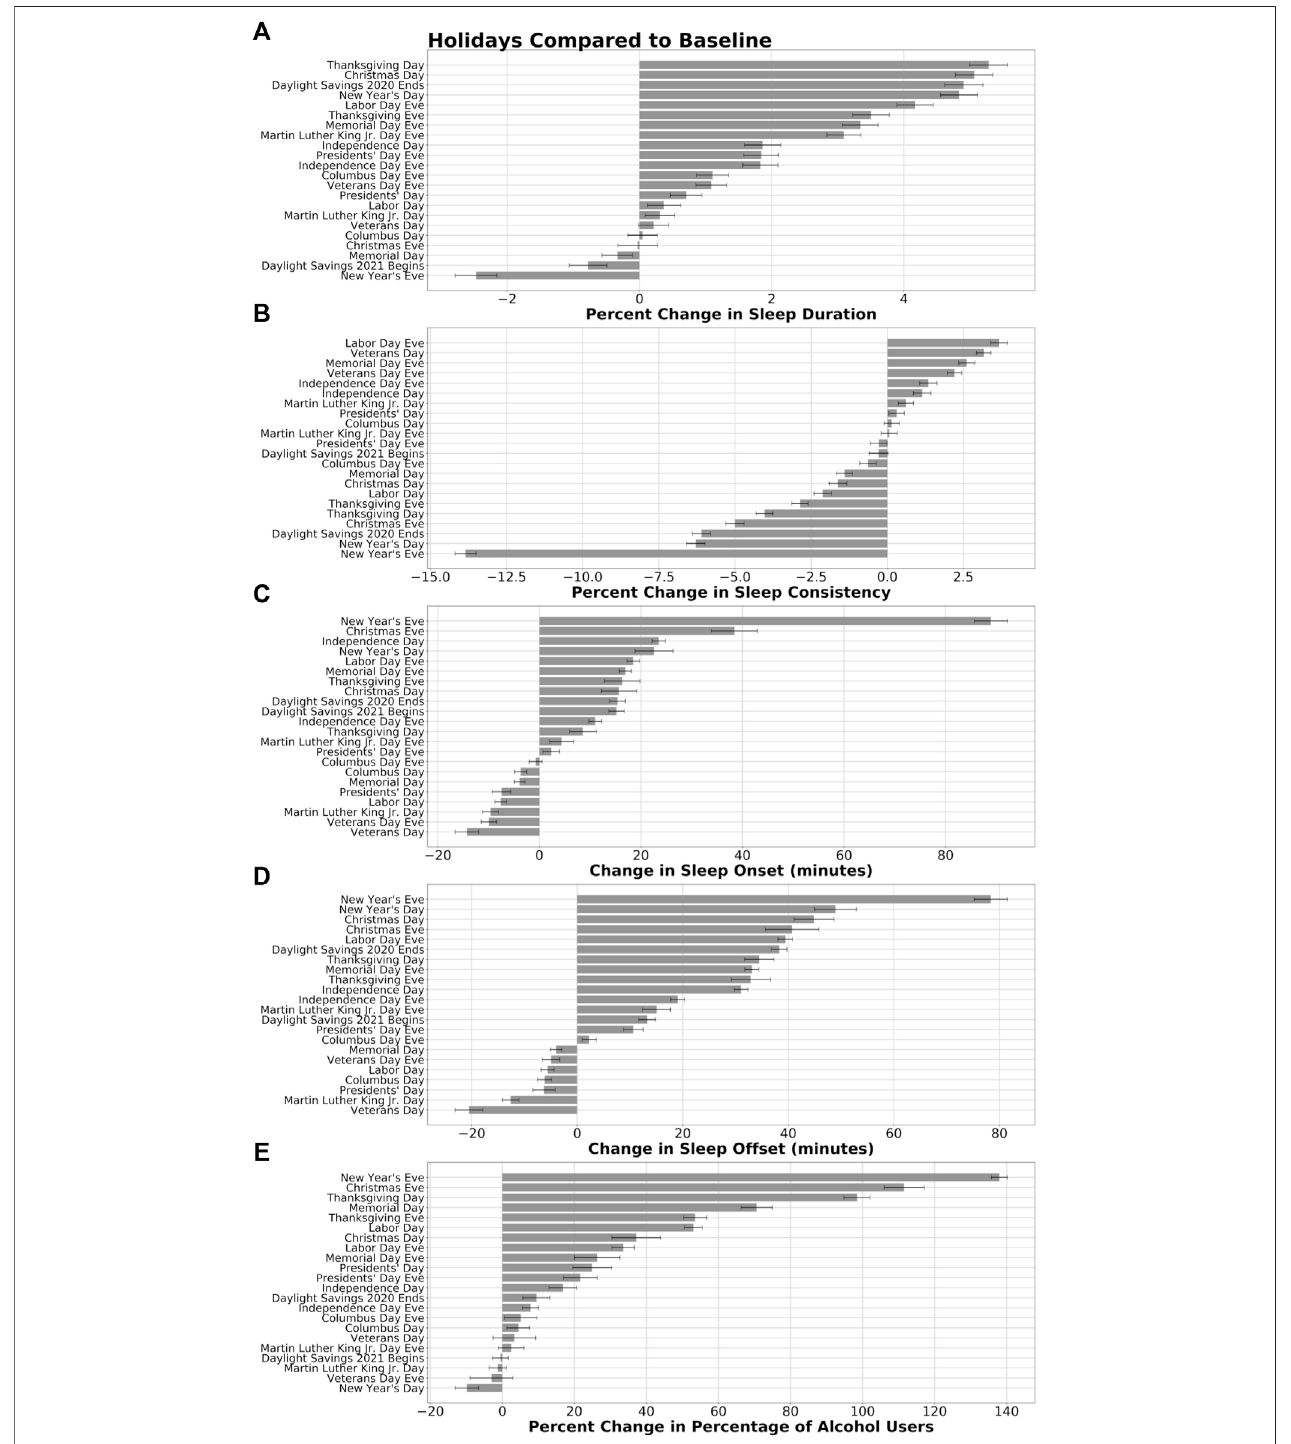
FIGURE 2 | Sleep and alcohol use during DST transitions and on holidays and their eves compared to baseline. The percent change from baseline sleep duration (A) and sleep consistency (B) , change in minutes of sleep onset and offset timing (C, D) , and percent change in the percentage of participants reporting alcohol use (E) were calculated across the sample for DST transitions and each of the US public holidays and eves are shown. For each measure, holidays, eves, and DST transitions were ranked from the largest increase to the largest decrease compared to baseline sleep and alcohol use measures. Error bars on sleep duration, consistency, andtimingpanelsrepresent95%con fi denceintervals.Errorbarsonthealcoholpanelrepresentthepropagationoferrorfrombinomialproportioncon fi denceintervalsof the holidays and their